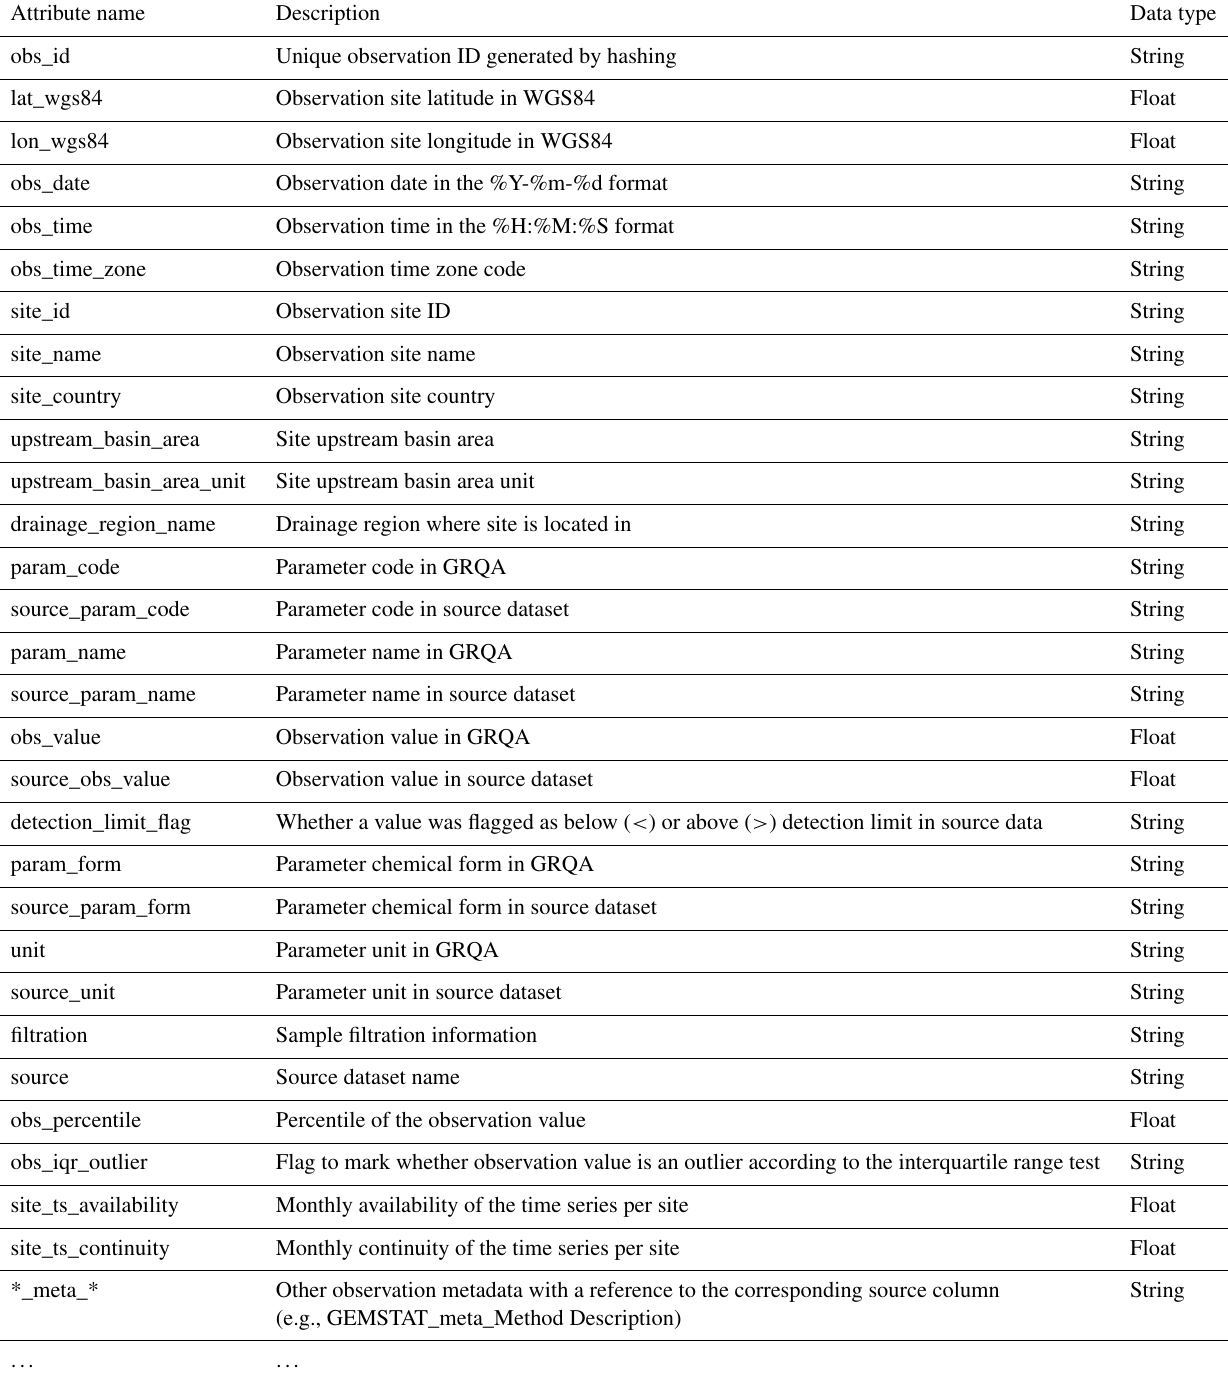
Table 6. Summary table of output water quality observation file